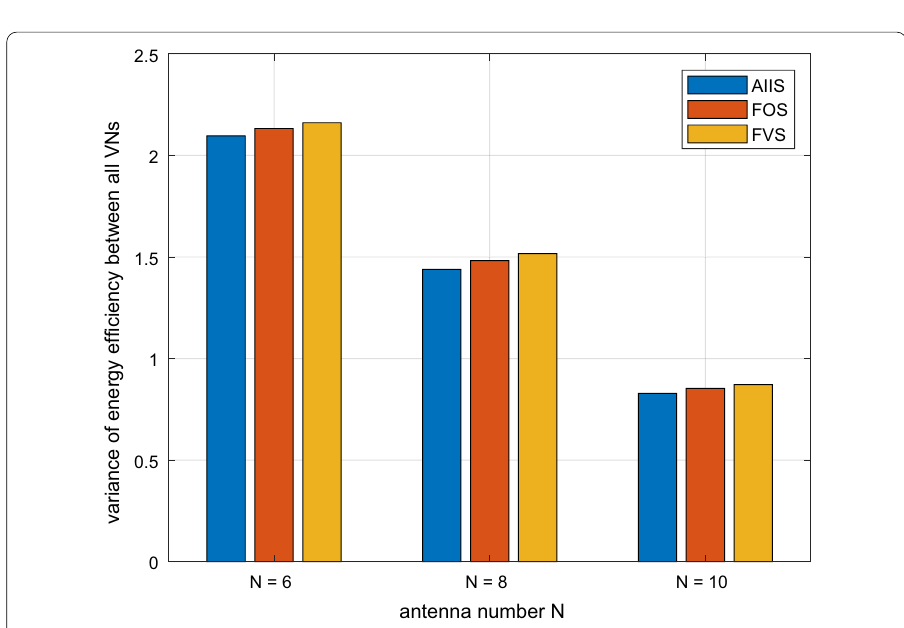
Fig. 8 The variance of energy efficiency between all vehicle nodes (VNs) under different antenna numbers